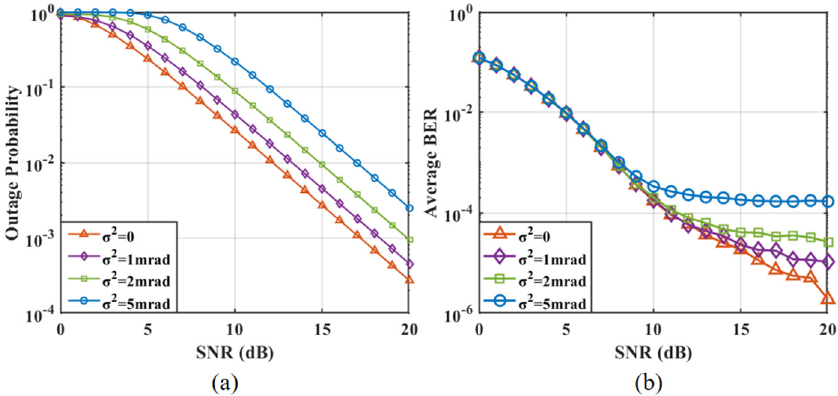
Figure 7. FSO communication performance with different wind resistances of the UAV in yaw motion at the same horizontal plane. ( a ) Outage probability; ( b ) average BER.